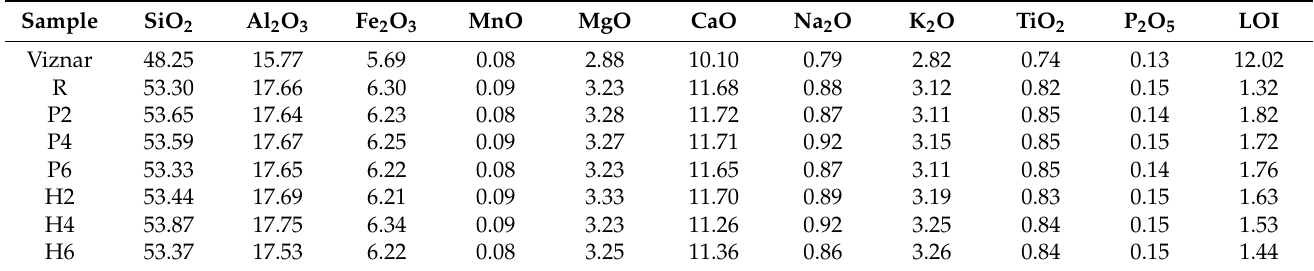
Table 2. Chemical analysis of the major oxides (in wt.%) in the raw material from Viznar and the fired bricks. LOI stands for loss of ignition. Sample abbreviations as in Table